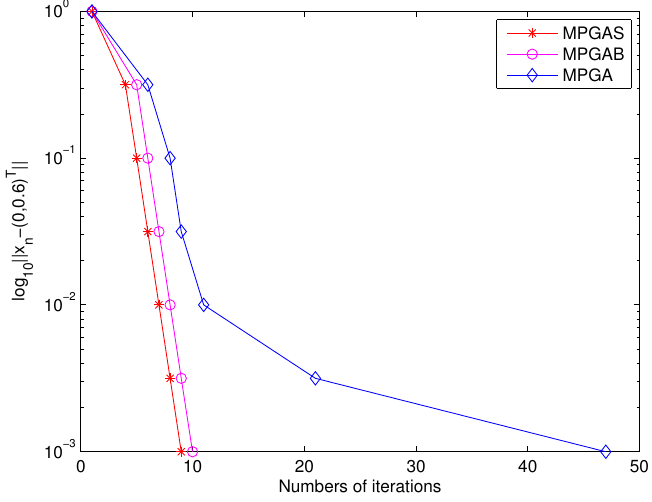
Figure 1. The number of iterations with Algorithm 1(MPGAS), algorithm (42)(MPGAB) and algorithm